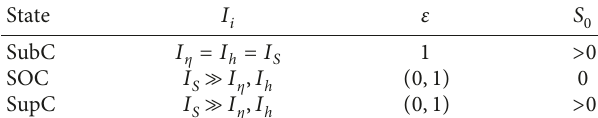
Table 2: Critical states of